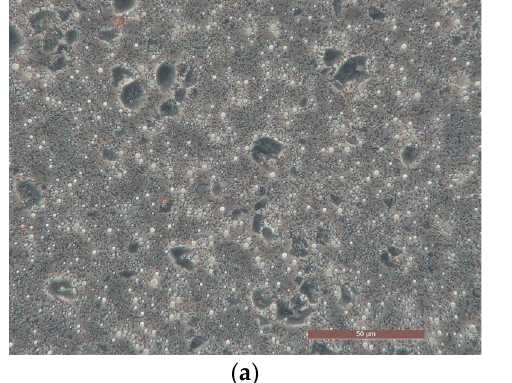
Figure 4. Optical microscopies with 40× magnification of emulsion AZ10 D03 ( a ) and AZ10 S03 ( b ) prepared with A-Z (ratio 1:1), 10% w/w of oily phase O and 0.3% w/w of polysaccharides D (Diutan gum) and S (Succinoglycan).